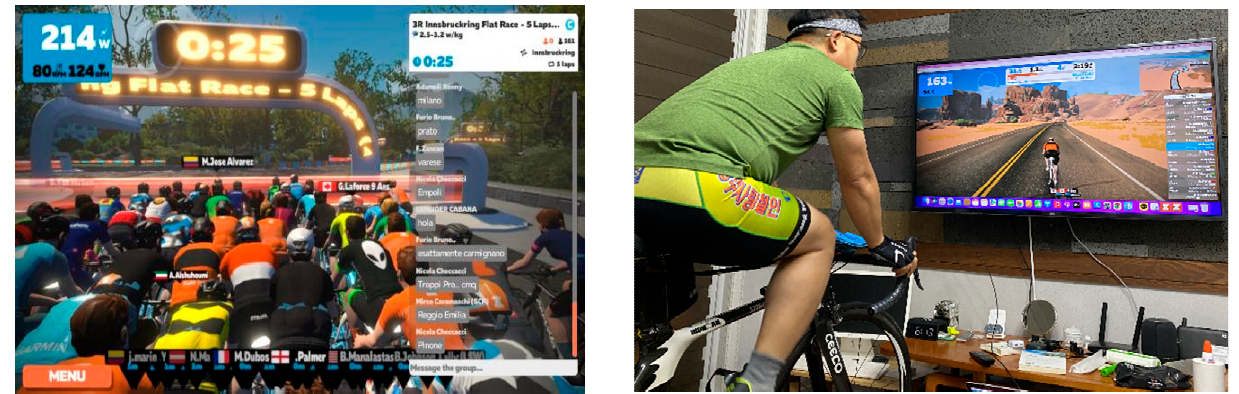
Figure 2. Zwift screen capture ( Left ); researchers playing Zwift application ( Right ). Source: https://blog.cyclestore.co.uk/zwift-racing-5-top-tips/ (Accessed on 5 March. 2022) ( Left ), a researcher’s photograph ( Right ).